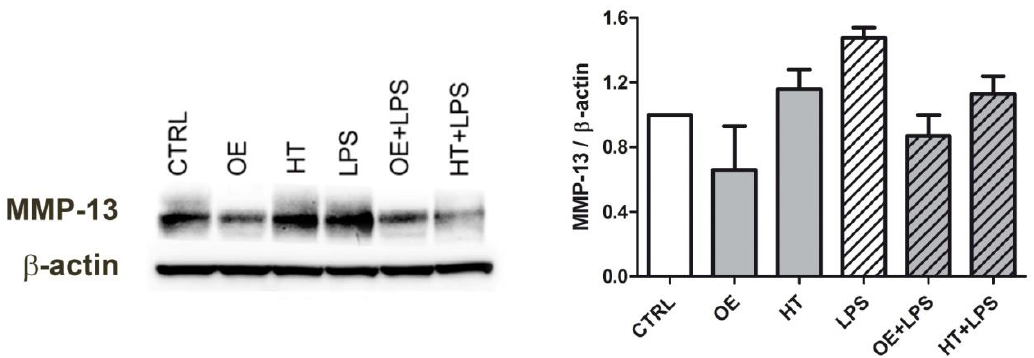
Figure 7. Inhibiting effects of OE and HT on LPS-induced MMP-13 expression in C28/I2 chondrocytes, following 6 h exposure to LPS. Right graph: quantification of MMP-13 intensity relative to β-actin (2 experiments).